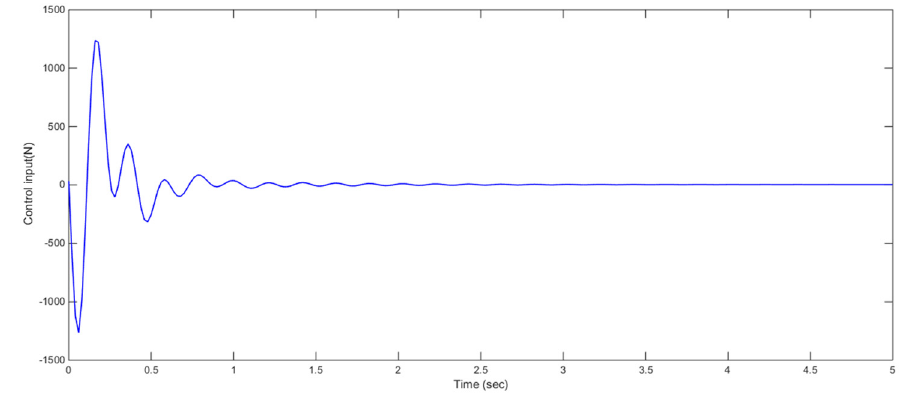
Figure 5. The control signal.